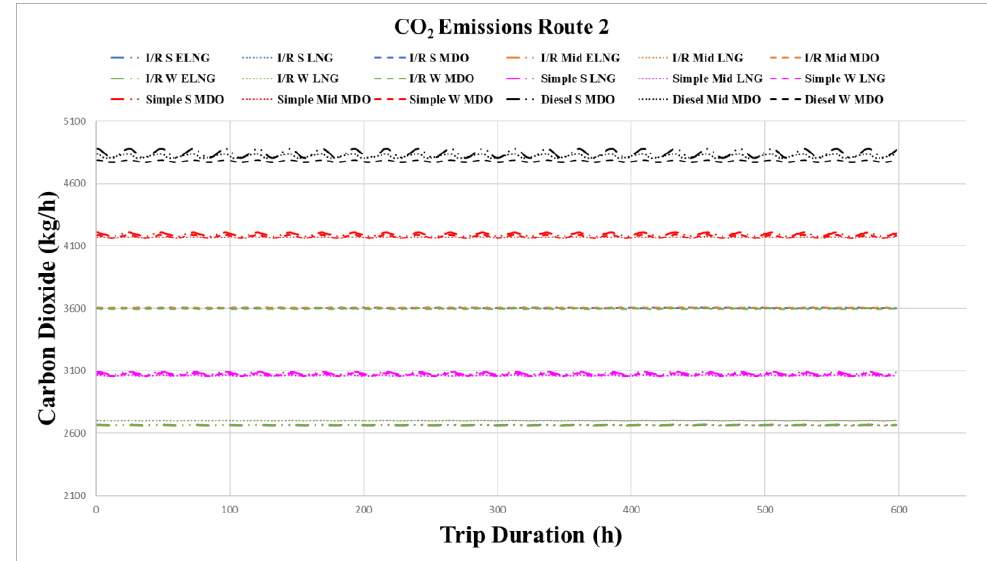
Figure 11. CO 2 emissions of various propulsion systems of the large container ship travelling be- tween Shanghai and Hamburg. I/R: intercooler/reheater CCGT; R: reheater CCGT; S simple CCGT; Diesel: two-stroke diesel engine; W: winter; Mid: midseason; S: summer.